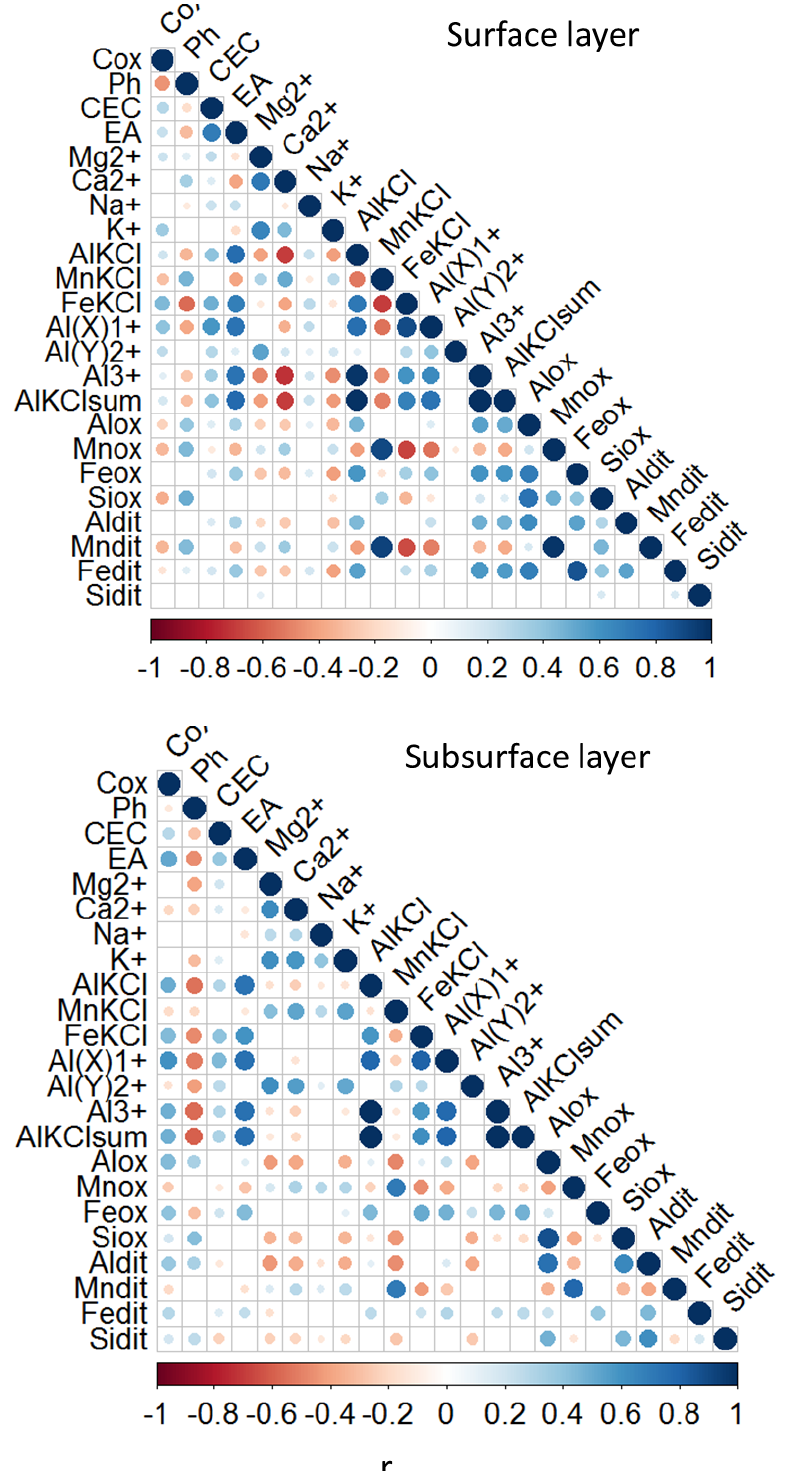
Figure 3. Pearson correlation coefficients for relationships between soil chemical properties for the surface and subsurface layers. Positive correlations are displayed in blue and negative correlations